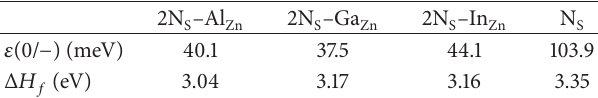
Table 1: Ionization energy 𝜀(0/−) and formation energy Δ𝐻 𝑓 of defect complexes in